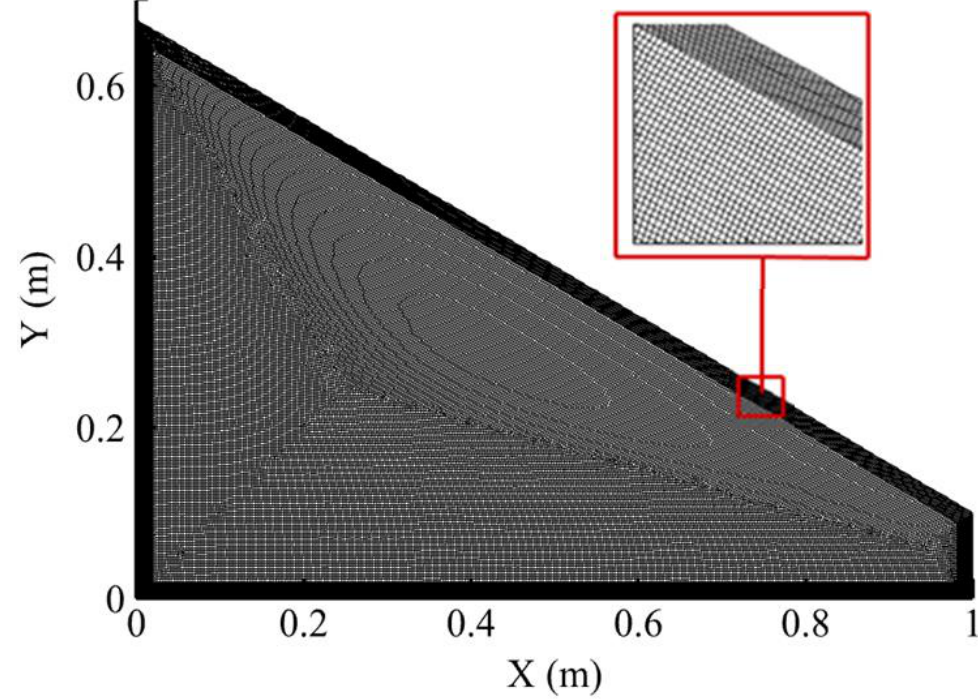
Figure 3. Computational mesh used in this study.